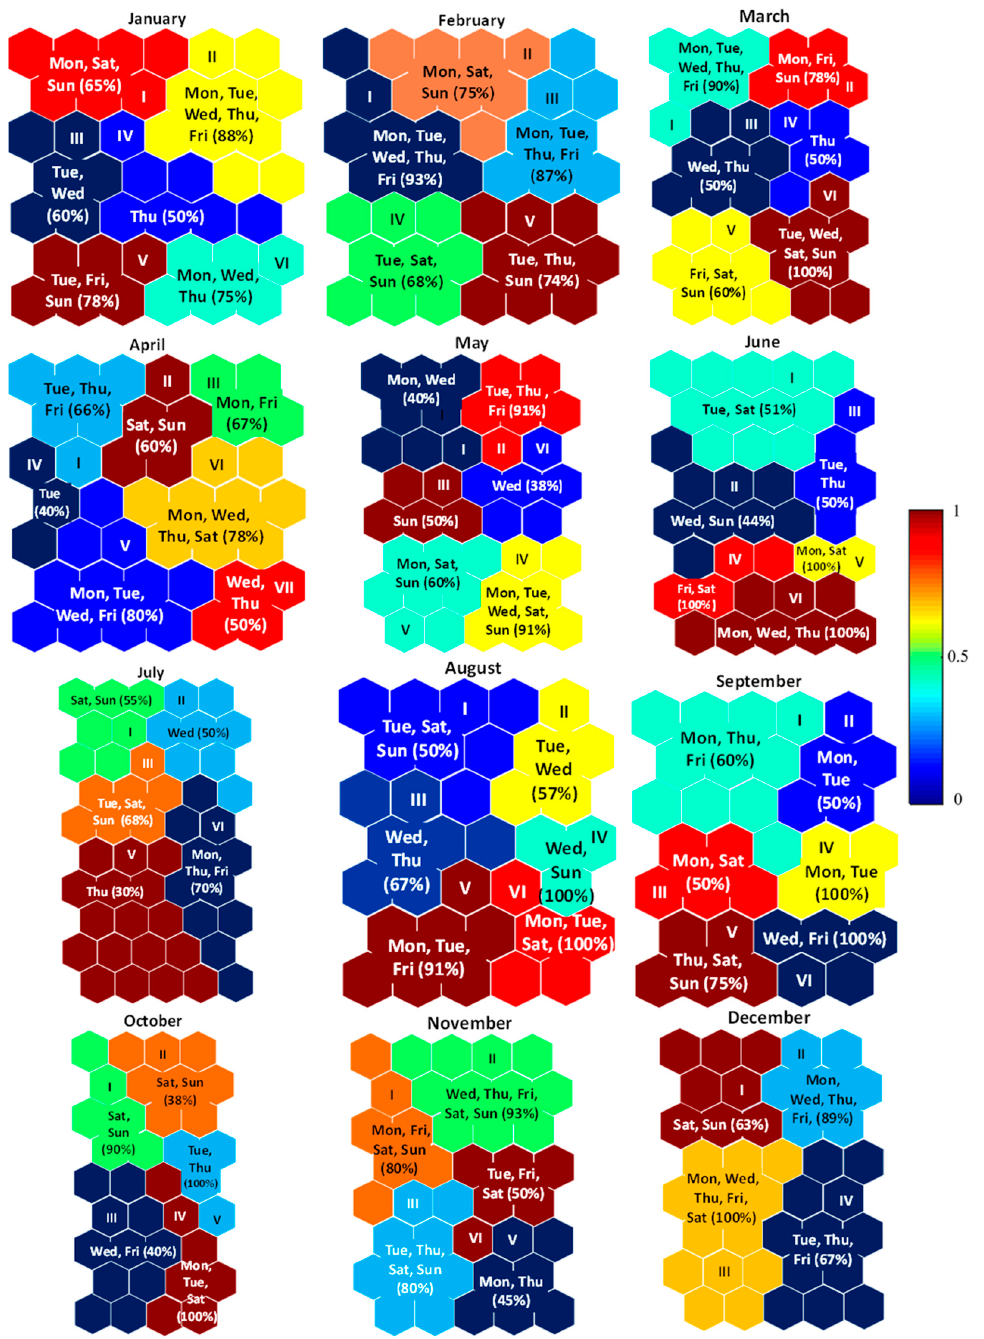
Figure 4. SOM clustering depiction of monthly daily water patterns with respect to each month based on the overall communities’ water consumption, temperature, and rainfall dataset of the period October 2015–December 2019. In each cluster, days with highest percent of occurrence are indicated as {days} with the relative occurrences (percentage) of the day in the cluster based on the level of water consumption. Clusters are colored, on a normalized scale of 0–1, as per the color bar (right), from lowest (blue) to highest (red) water usage.